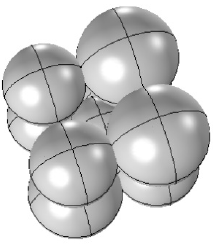
Figure 5. The spheres model following the Rayleigh distribution function in a microelement.